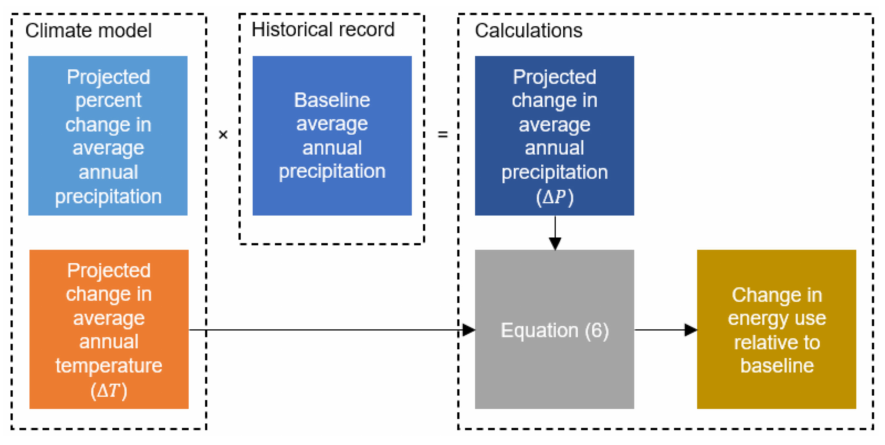
Figure 1. Diagram of change in energy use